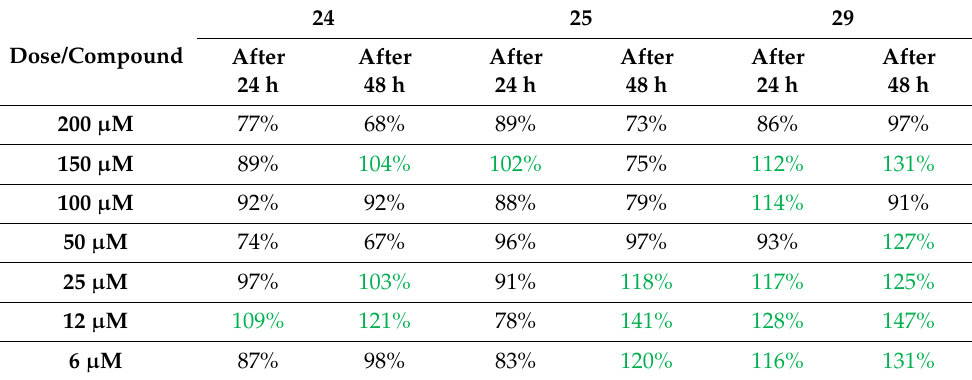
Table 3. The cell proliferation in % according to control after 24 and 48 h exposition on studied compounds in A549 cell